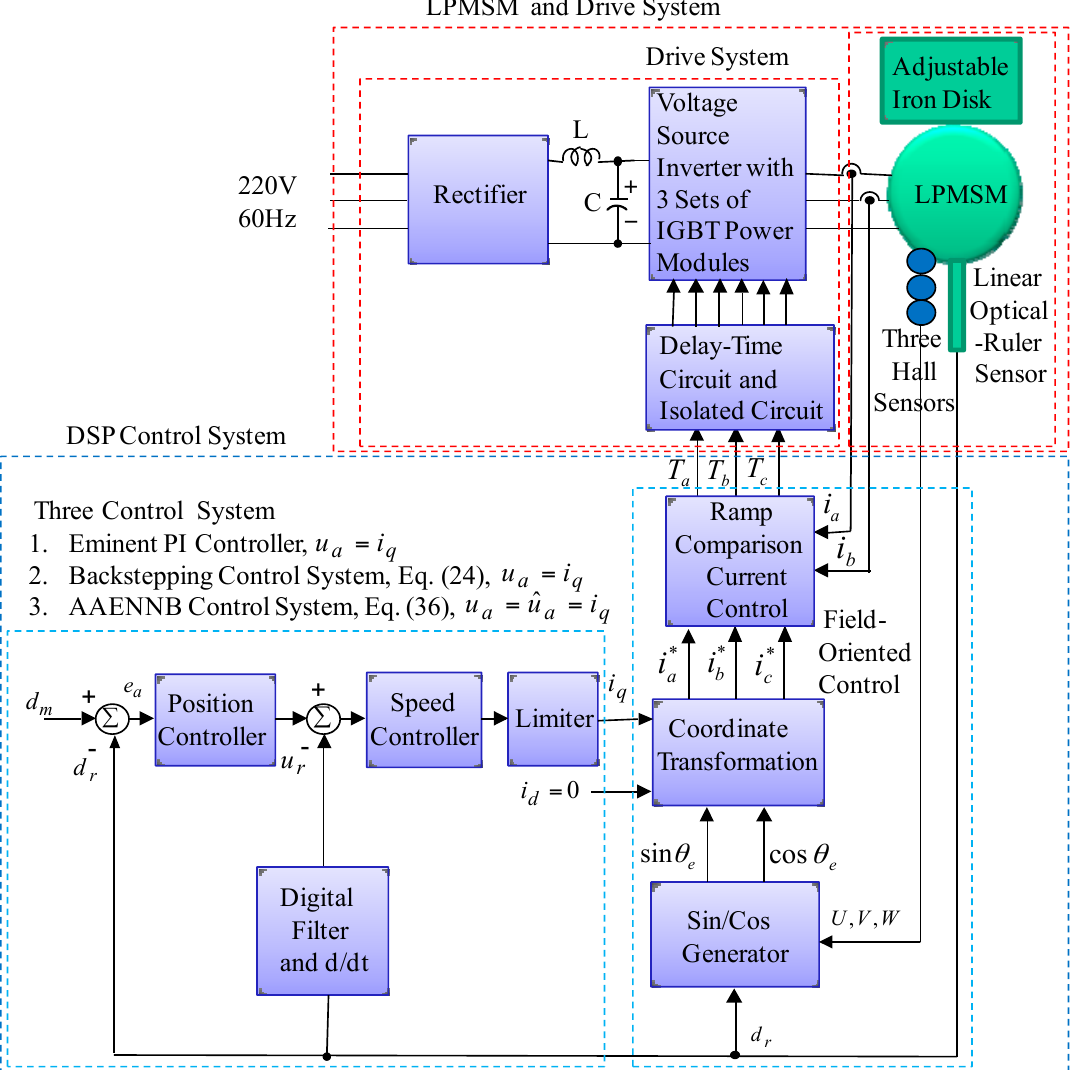
Figure 1. Formation of LPMSM drive system with field-oriented control using DSP control system.